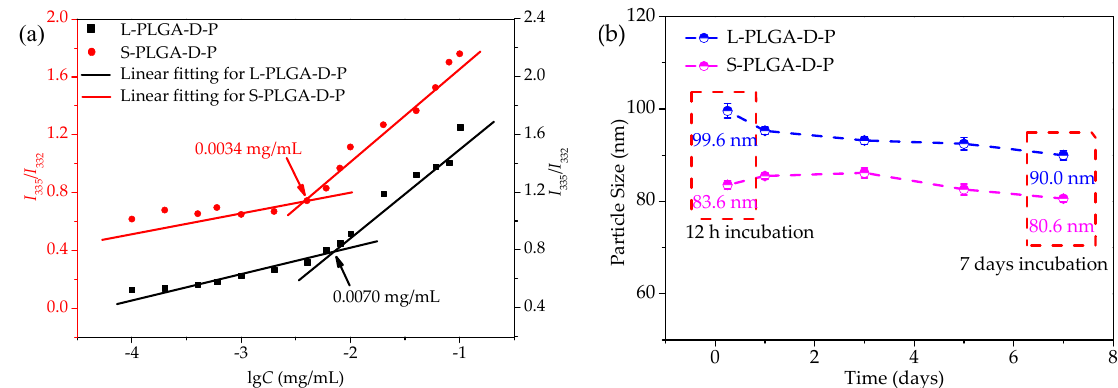
Figure 3. ( a ) Dependency of the ratios of fluorescent intensity ( I 335 / I 332 ) on polymer concentration in aqueous solution. ( b ) The effects of incubate time on the particle sizes of polymeric micelles in PBS with pH 7.4 at room temperature determined by DLS.